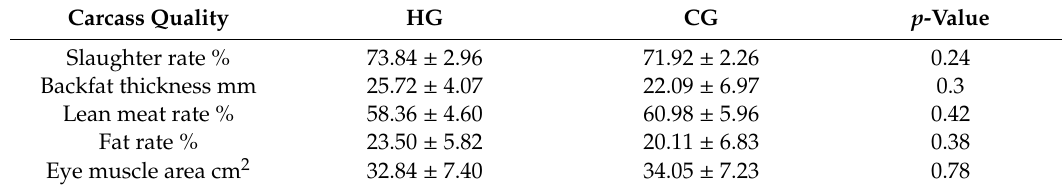
Table 6. Effect of gentle handling on carcass quality of finishing pigs (mean ± standard deviation) ( p < 0.05).